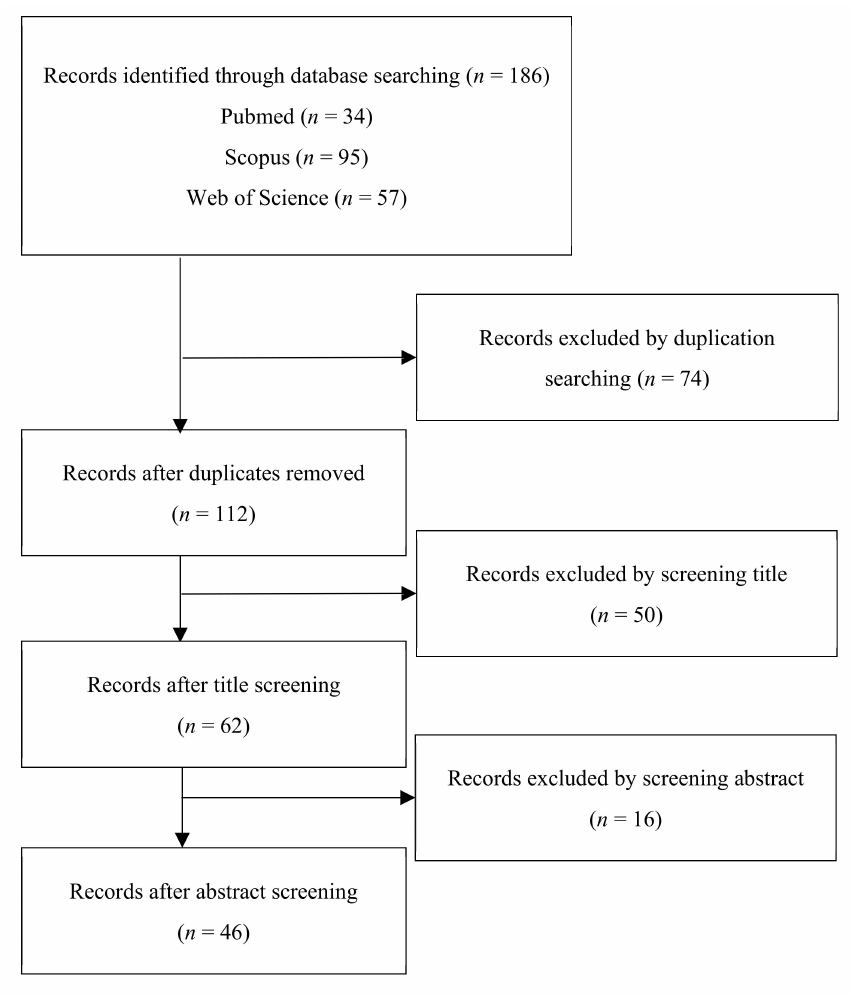
Figure 1. Flowchart of searched and reviewed literature (modified from